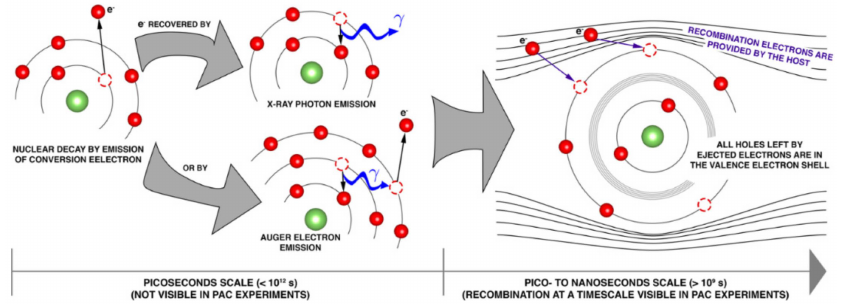
Figure 2. Schematic representation of electron cascade after ejection of conversion electron from nuclear decay. Electrons from higher shells de-excite to fill the vacant lower-energy shells, emitting either characteristic X-rays or Auger electrons or both. This process occurs on a time scale on the order of picoseconds, which is three orders of magnitude faster than the nanosecond time resolution of ( 181 Hf → 181 Ta) TDPAC spectroscopy. The electron cascade ends once the vacancy induced by the ejection of the conversion electron reaches the valence shell and is filled by recombination electrons provided by the host material. If the electron recombination process occurs on a timescale greater than nanoseconds, then the dynamic e − γ TDPAC signal differs from the γ − γ TDPAC signal. Reprinted with permission from Ref. [31] under the Creative Commons Attribution 4.0 International